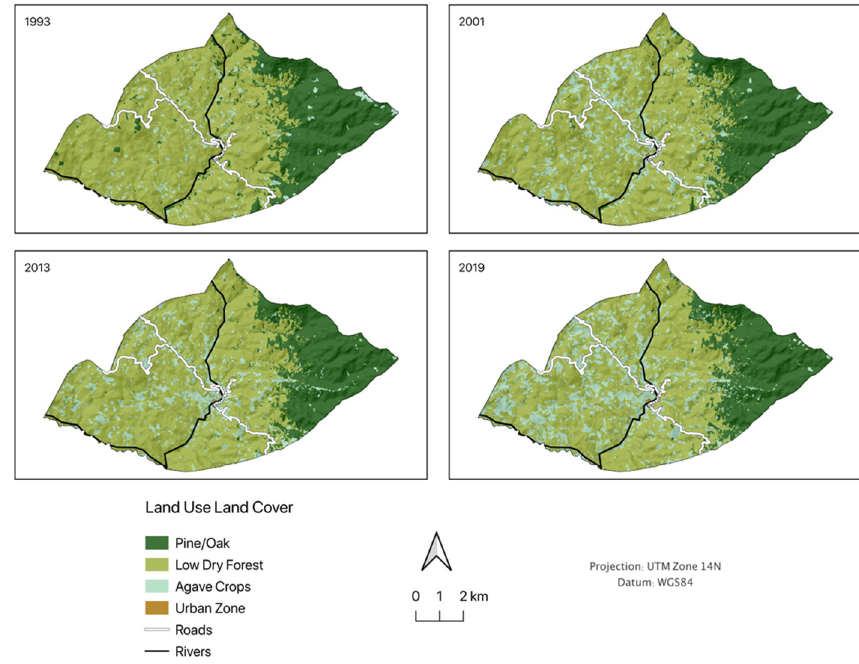
Figure 5. LULC maps San Juan del Río. Table 6. LULC change